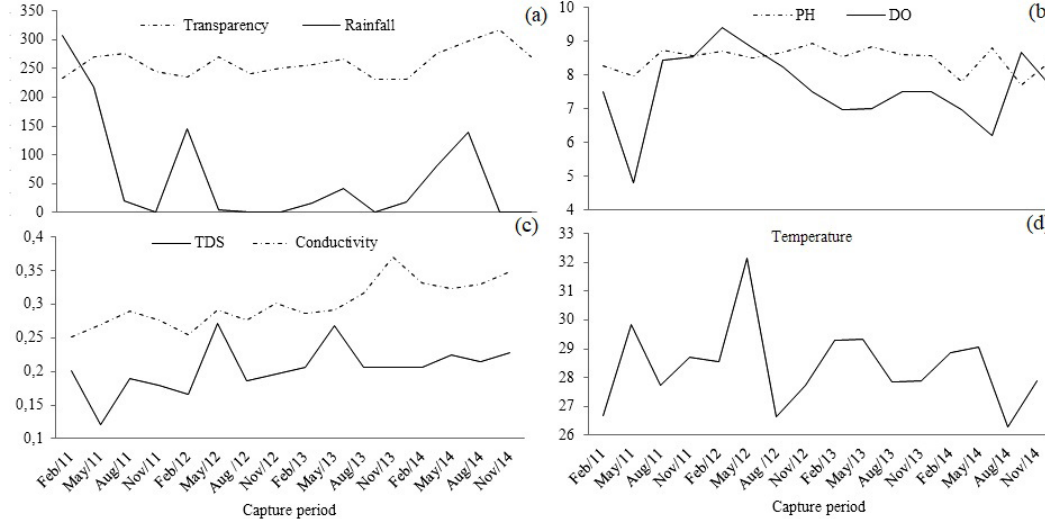
Figure 3. Transparency data (cm), Rainfall (mm) (a), pH, Dissolved Oxygen (DO) (mg/l) (b), Conductivity (μS.cm-1), Total Dissolved Solids (TDS) (g/l) (c), water Temperature (°C) (d), collected quarterly, between February 2011 and November 2014, at the Santa Cruz Reservoir, Rio Grande do Norte,